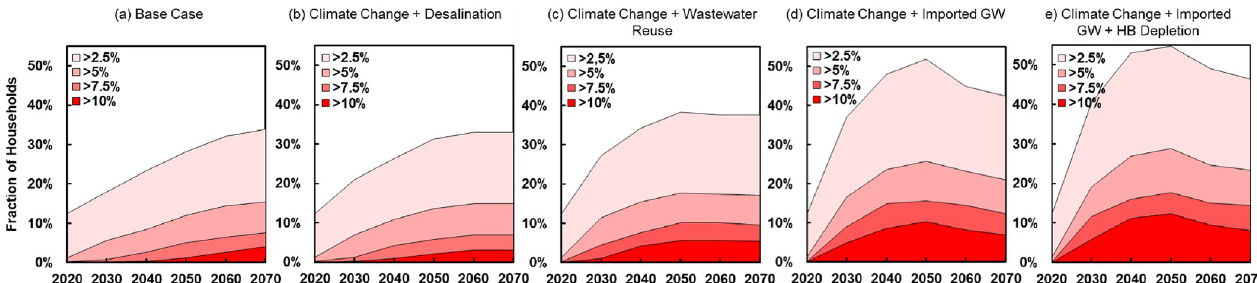
Fig 5. Projected, household-weighted average fraction of population in EPW spending more than a given fraction of income for municipal water over the period 2020–2070 for each water supply scenario. Source: Work of the authors.